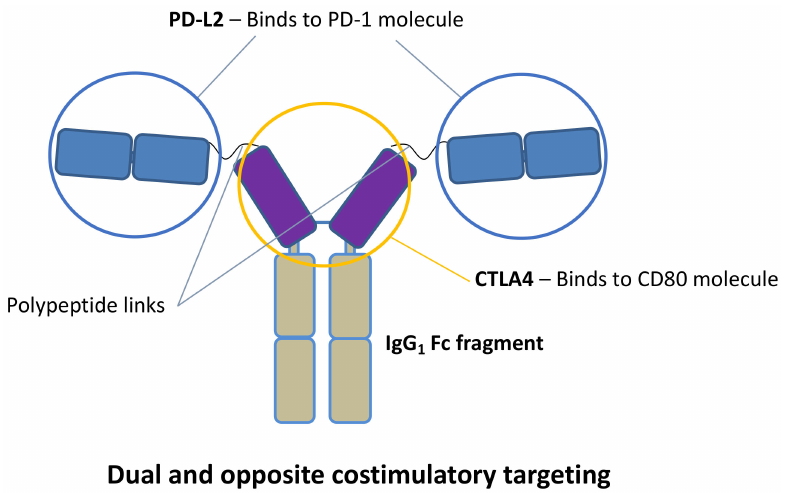
Figure 1. HYBRI protein structure.